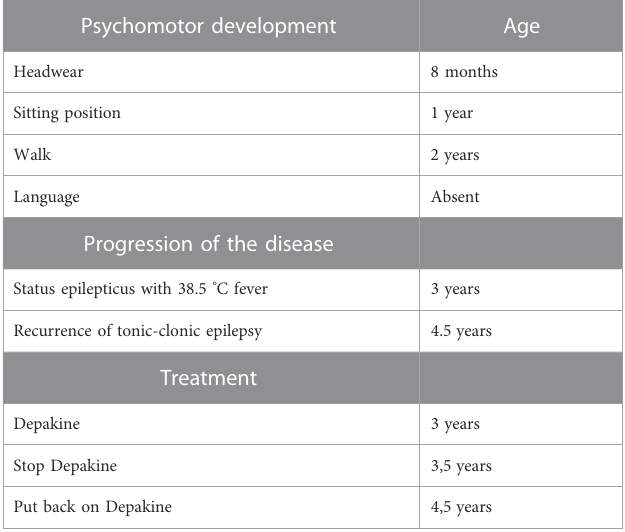
TABLE 1 Relevant data from the episode of